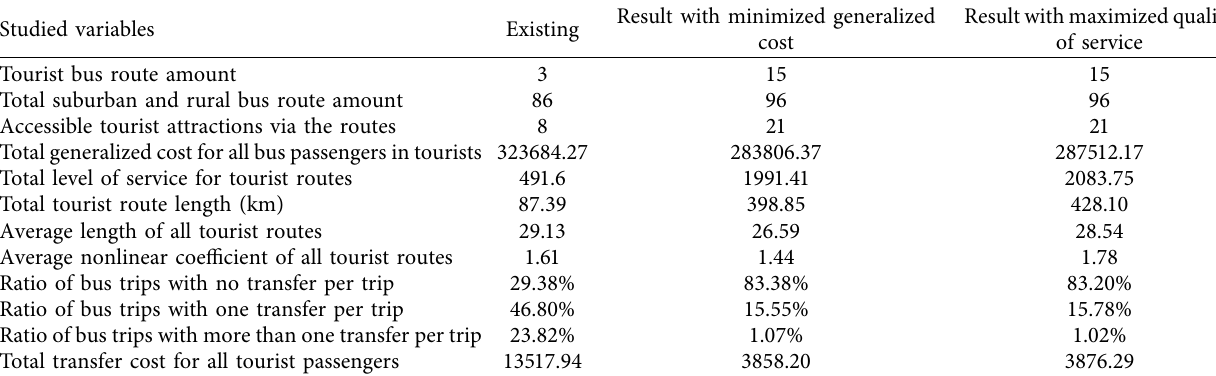
Table 6: Results of tourist bus routes after the design compared to the existing